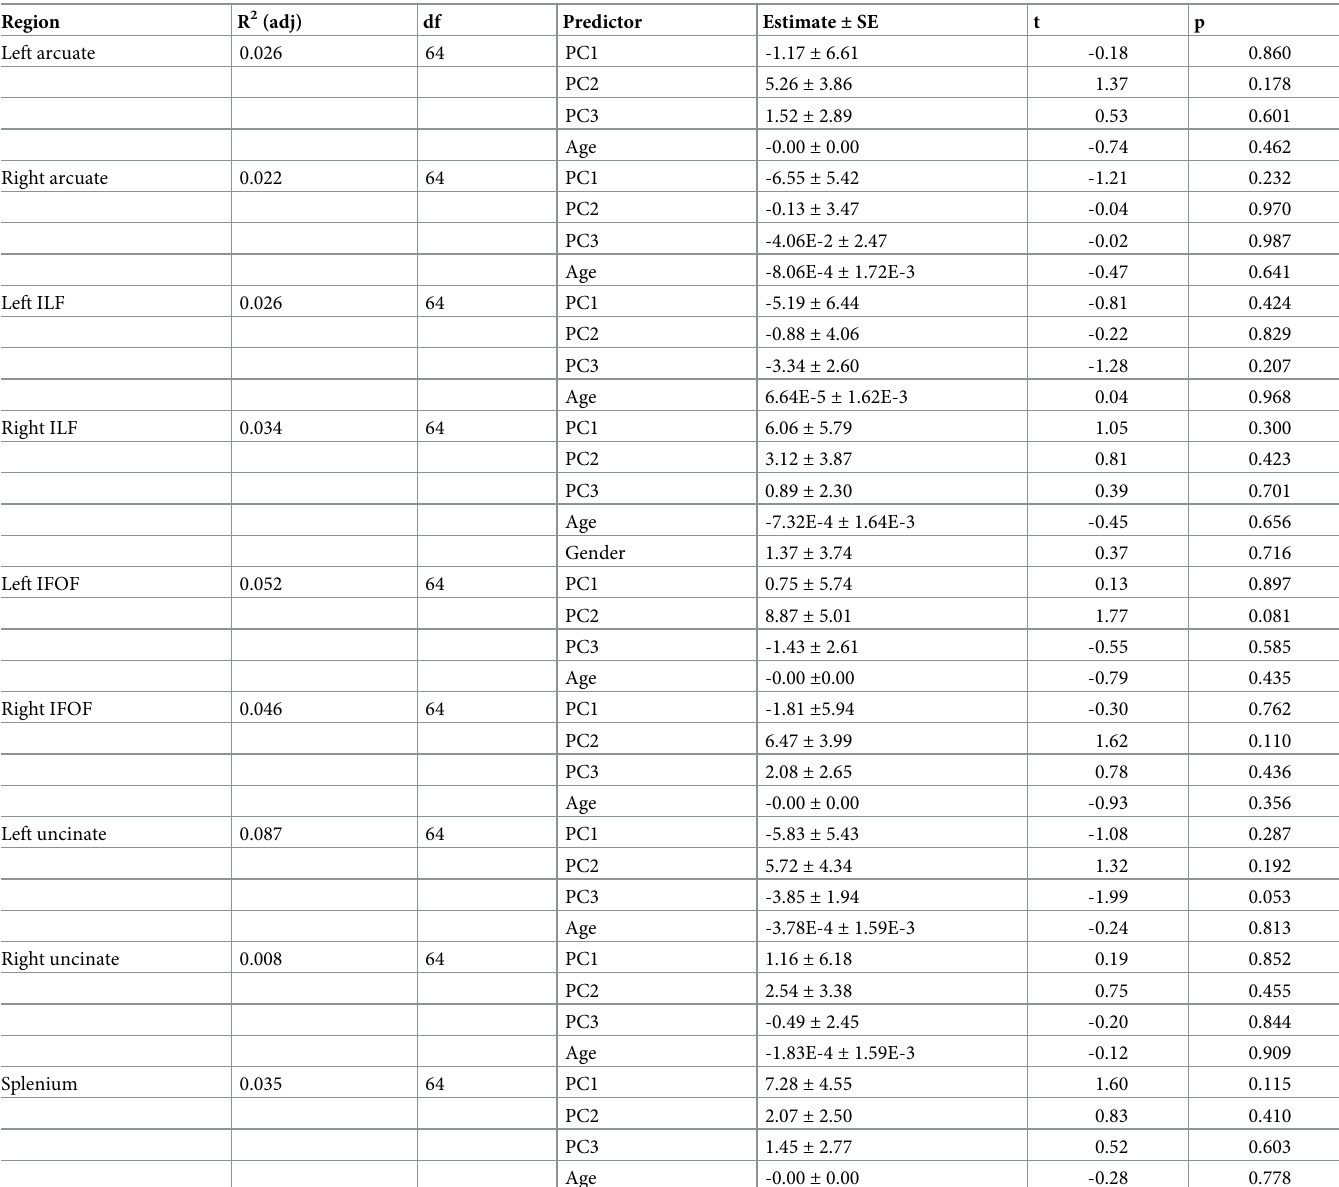
Table 1. Parameters for mixed effects models linking principal components to Total Reading (formula: Total Reading ~ PC 1 + PC 2 + PC 3 + Age + (1| Subject )). Region R 2 (adj)